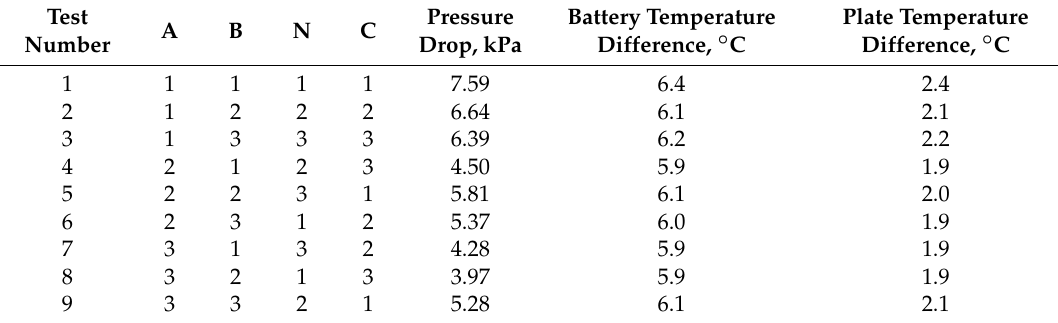
Table 5. Orthogonal test results.